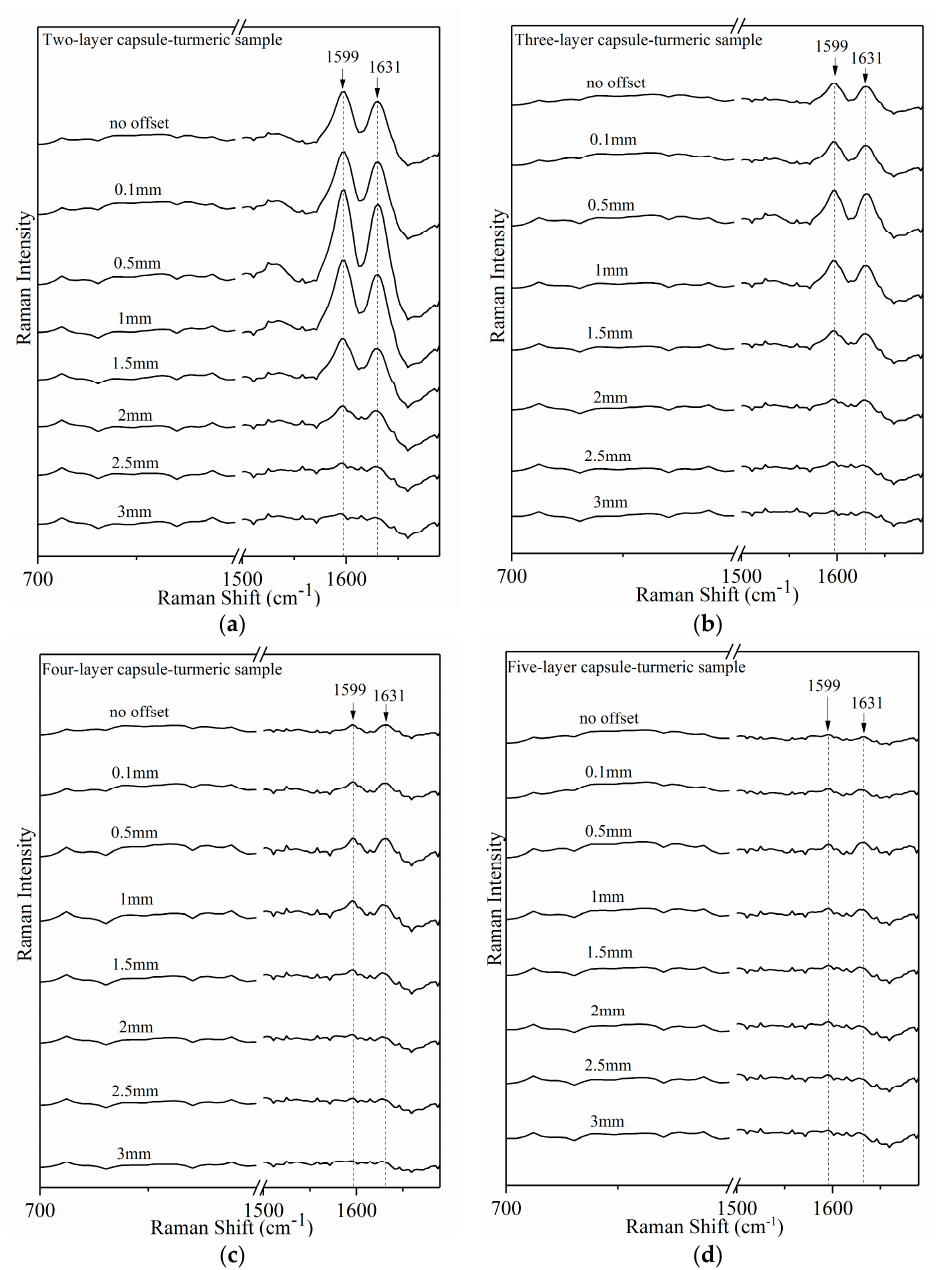
Figure 10. Spatially offset Raman spectra of turmeric powder packaged inside: two-layer ( a ); three-layer ( b ); four-layer ( c ); and, five-layer ( d ) capsule.